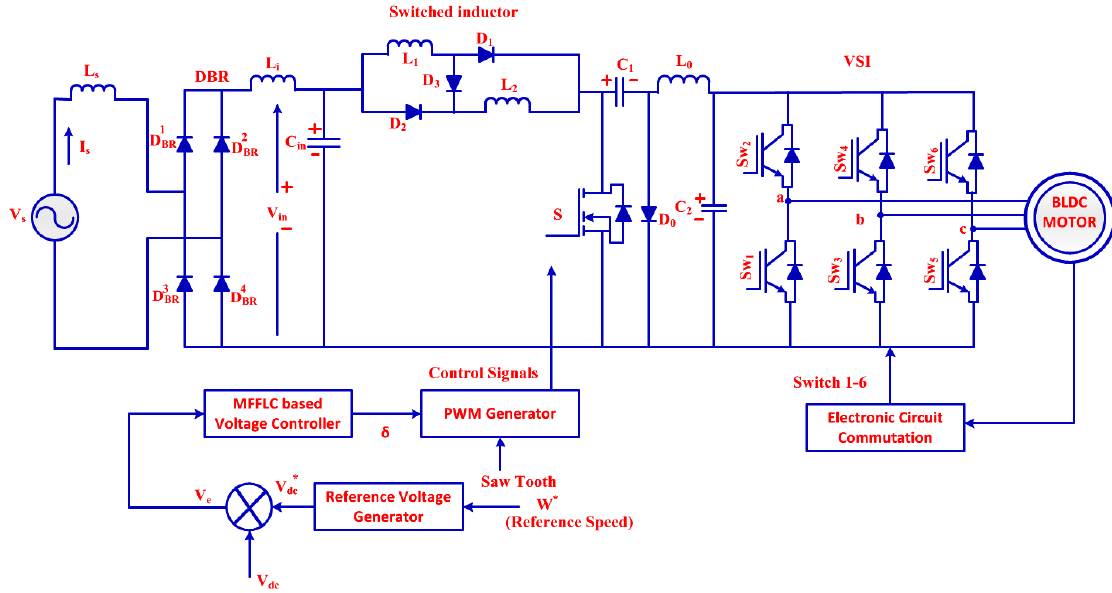
Figure 1. Schematic structure of integrated Cuk converter based controlling strategy for brushless DC motor (BLDCM). motor